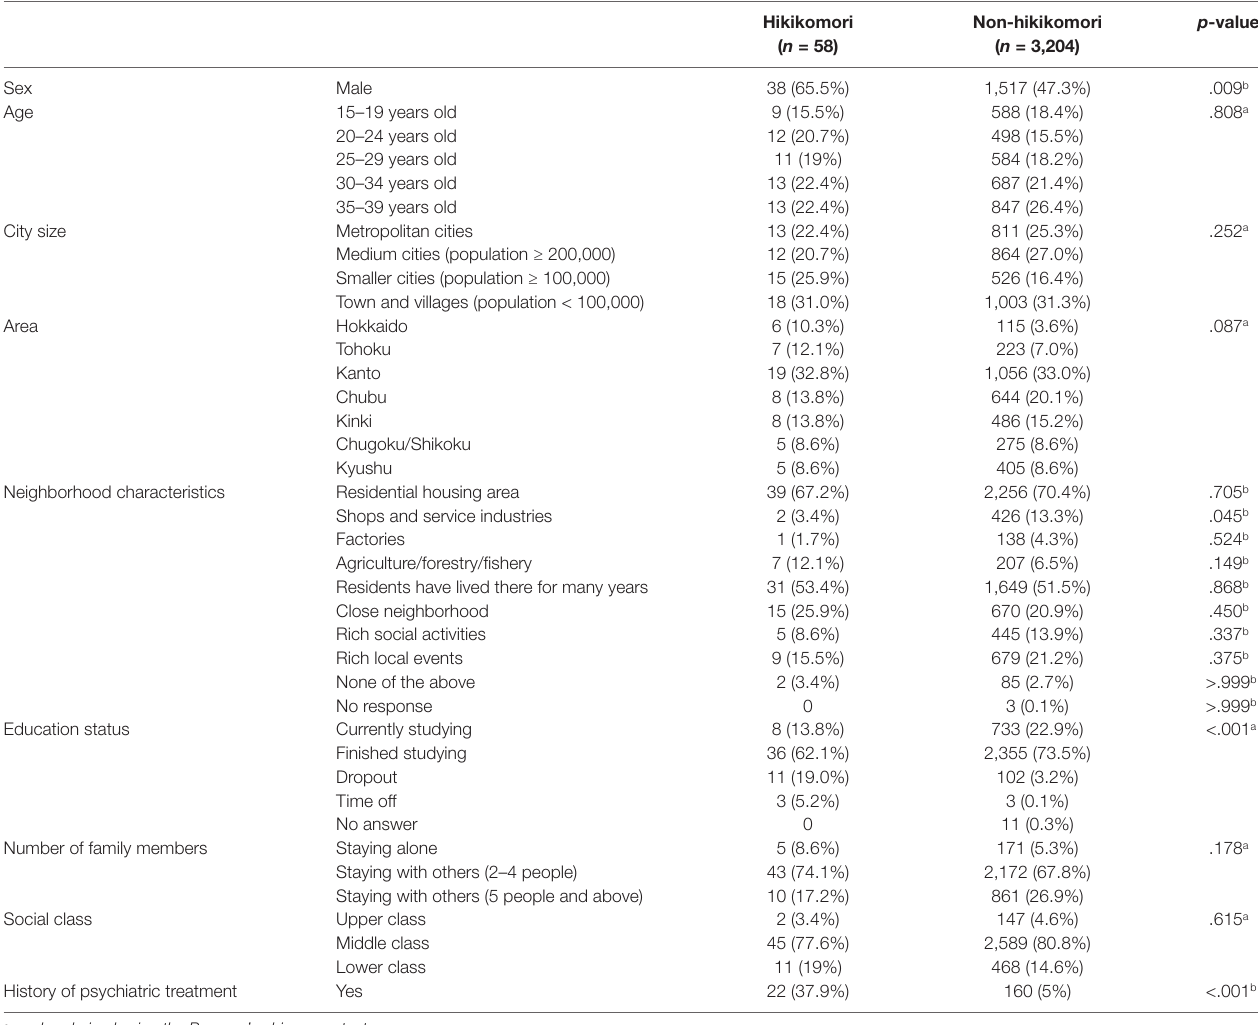
TABLE 1 | Basic characteristics of the participants ( N = 3,262).